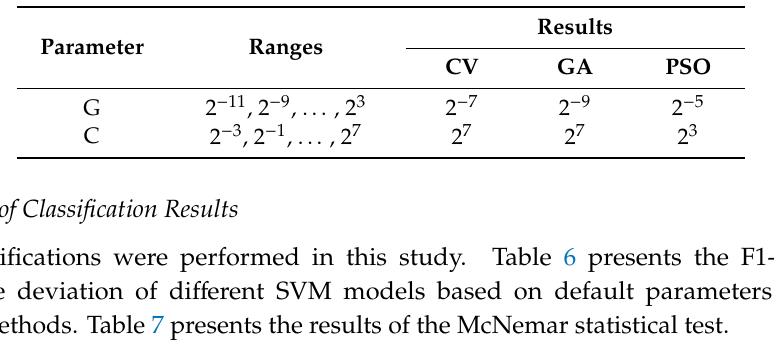
Table 5. Parameter of optimization results.